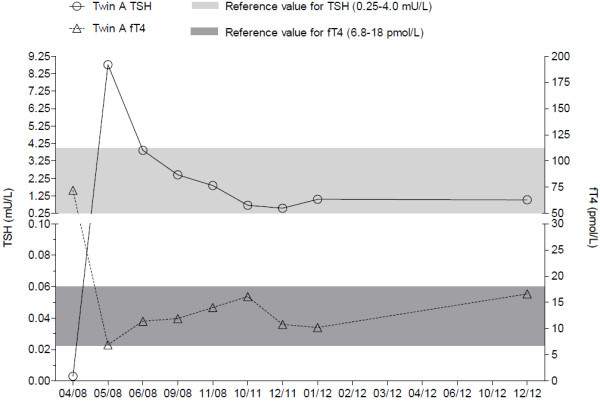
Timeline of TSH and fT4 for twin A.